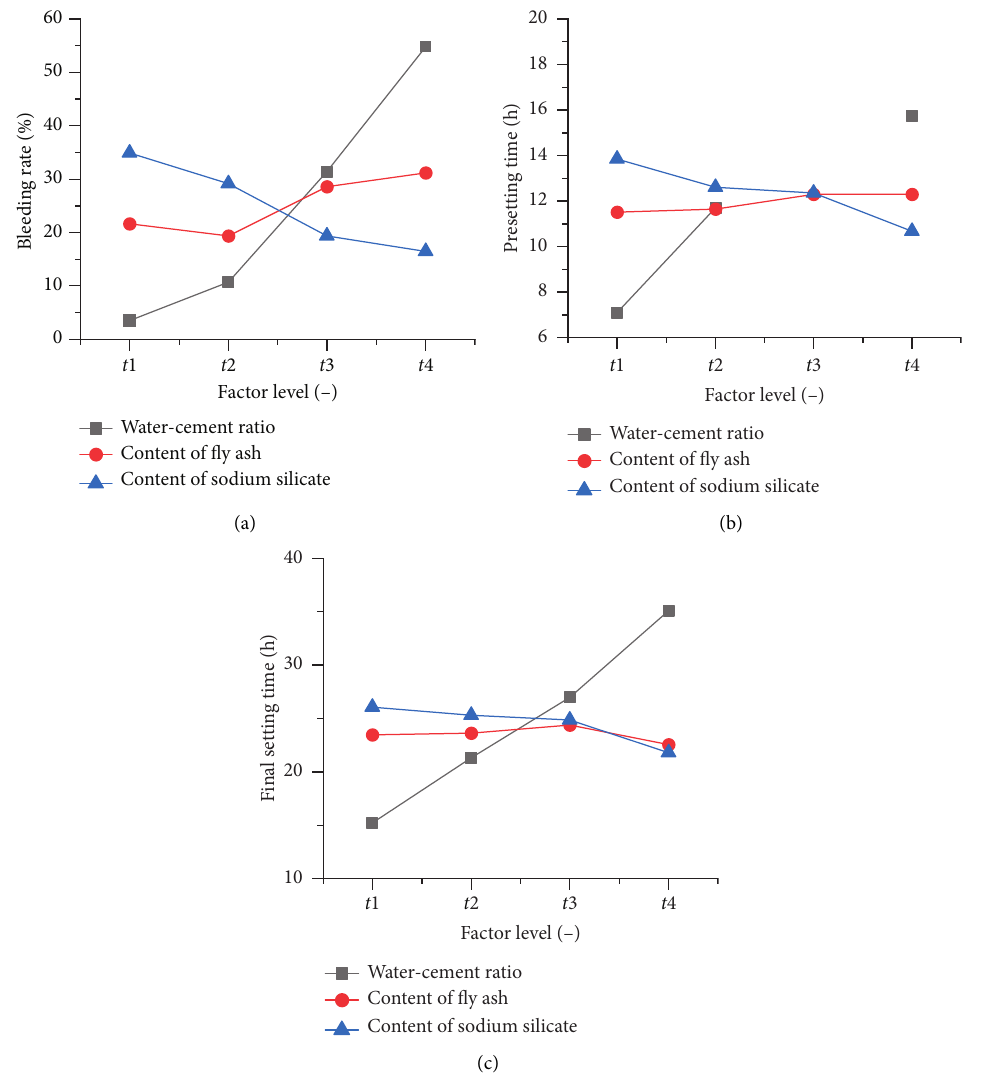
Figure 1: Measured (a) bleeding rate, (b) presetting time, and (c) final setting time at various factor